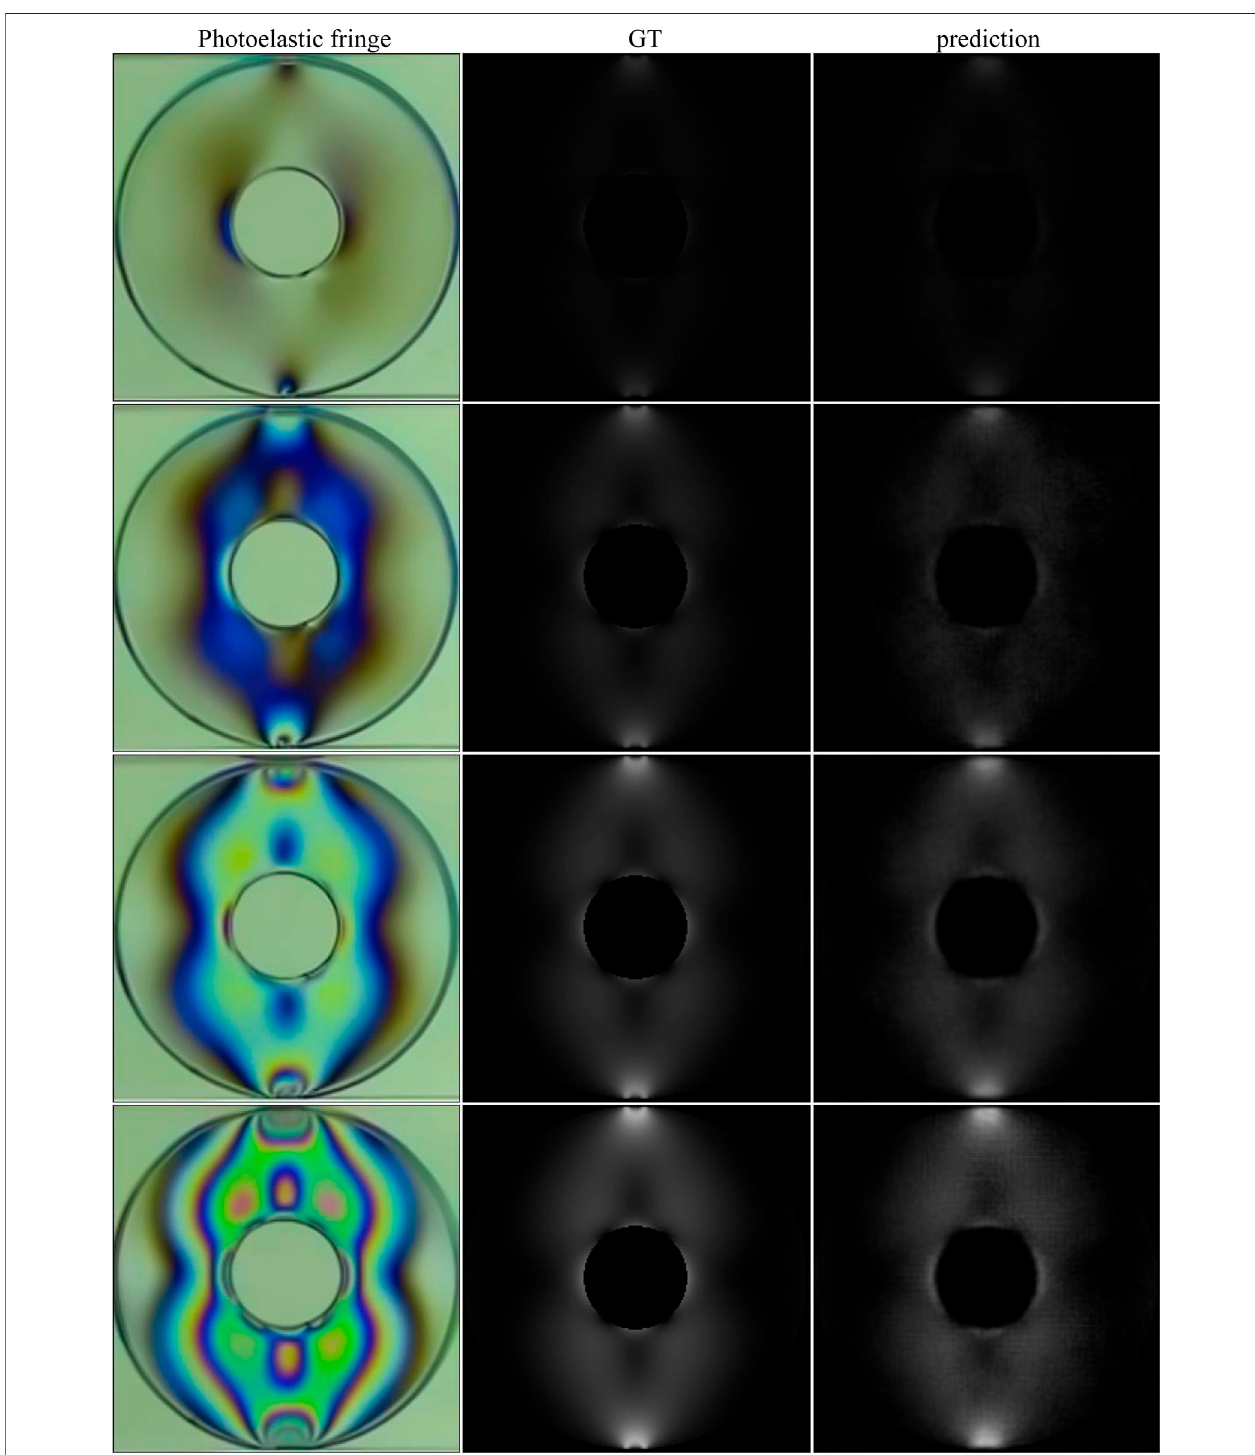
FIGURE 11 | Stress recovery results of experimental cases. First column: photoelastic color fringe pattern; second column: ground truth generated by simulation; third column: predicted stress map.